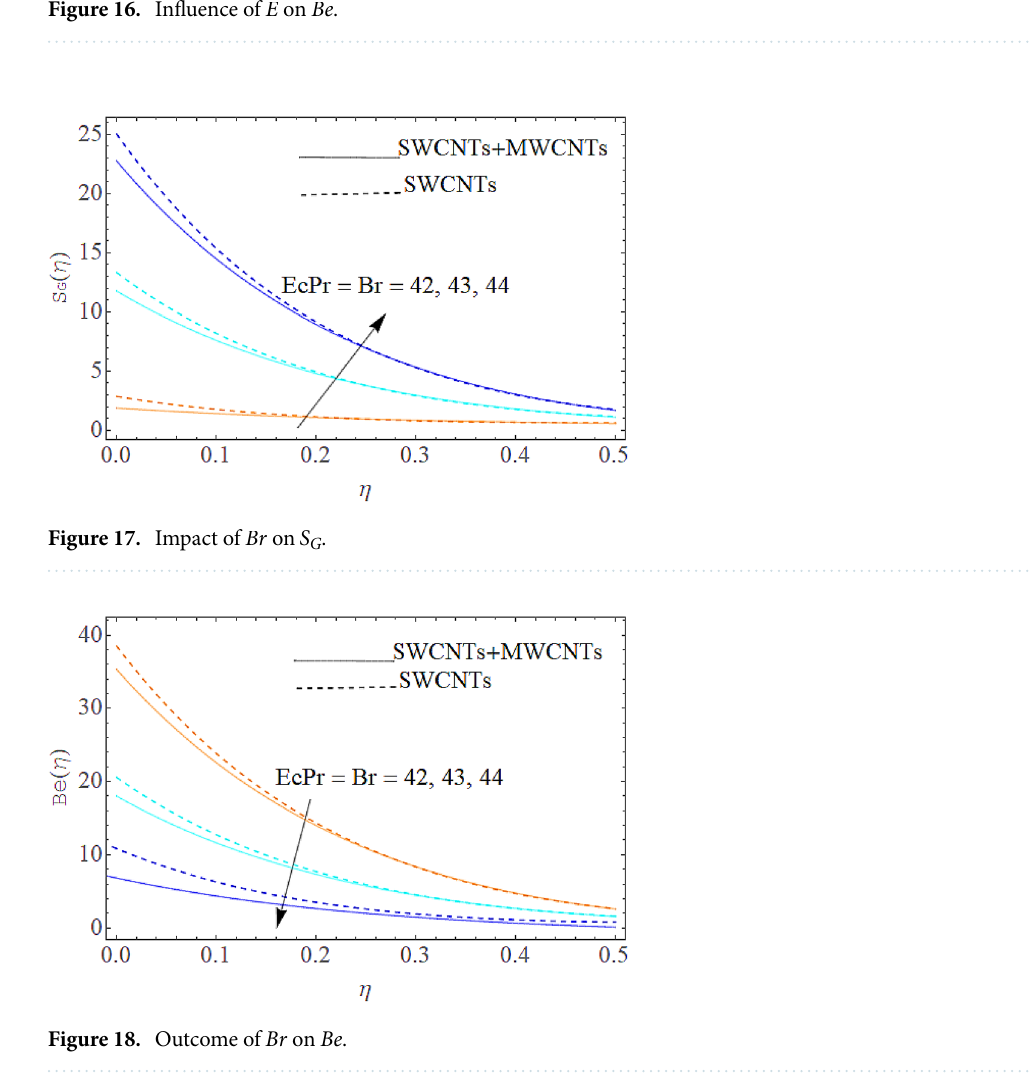
Figure 16. Influence of E on Be .